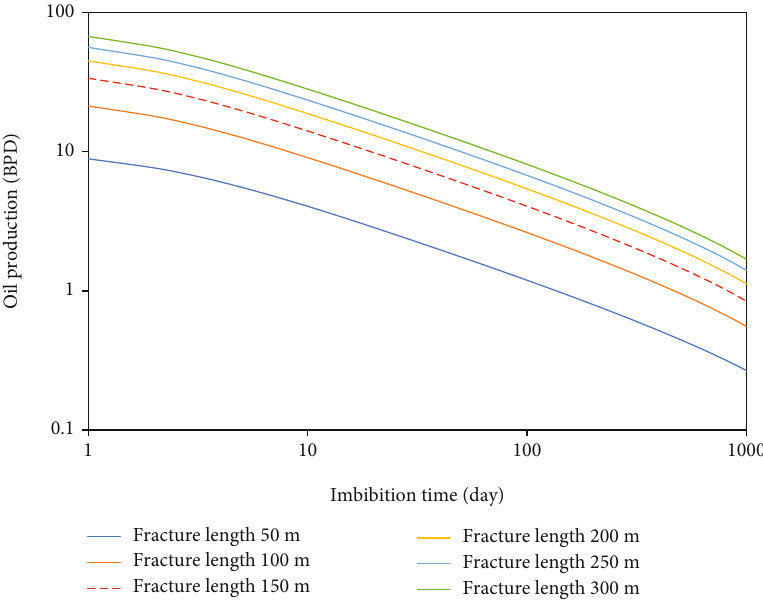
Figure 14: Relationship between the fracture length and oil production.